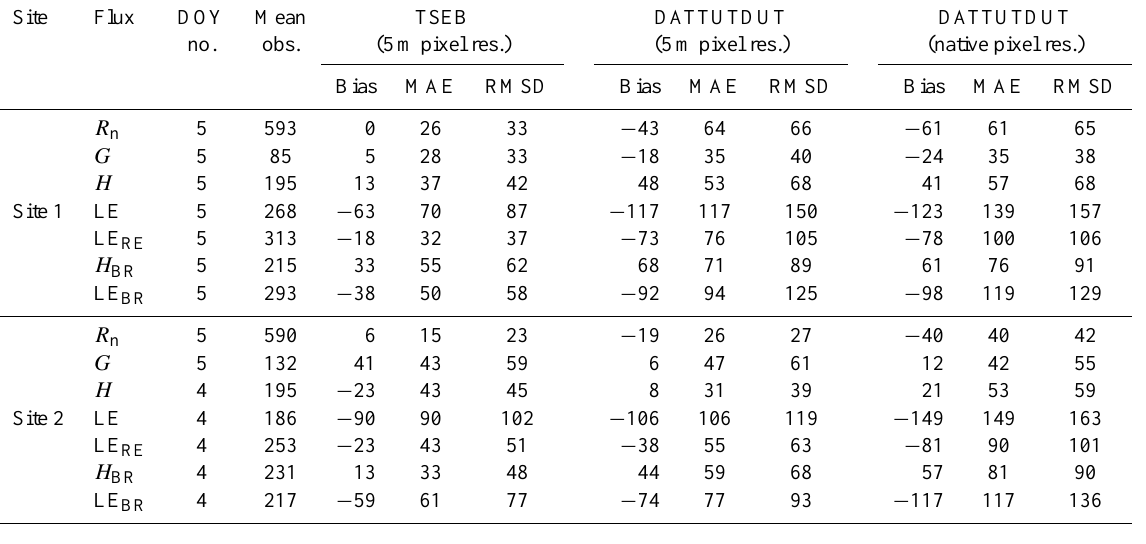
Table 2. Difference statistics describing comparisons between modeled fluxes from TSEB and DATTUTDUT at the overpass time and observations (original and with adjustments using the RE and BR methods for energy balance closure) (Wm − 2 ).